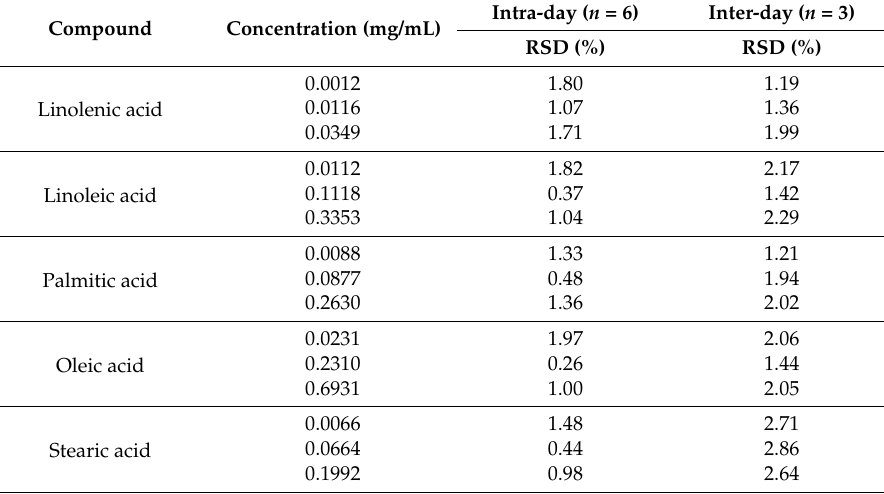
Table 2. Intra-day and inter-day precision of standard solutions.